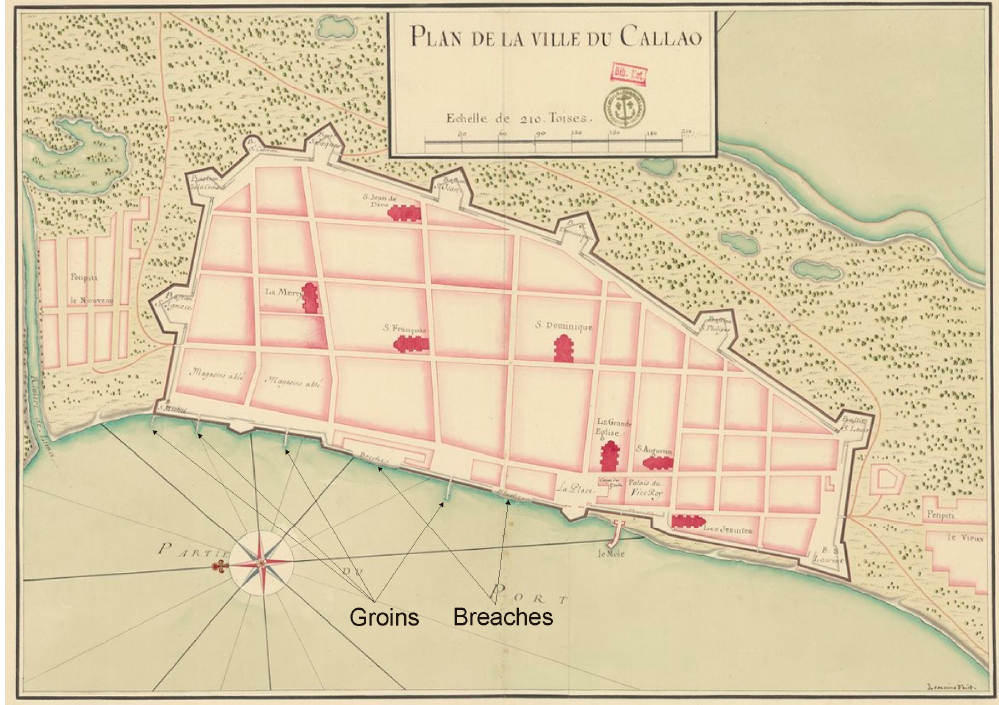
Figure 7. Groins in Callao (1724–1727) in a city plan copied by Lemoine [33]. Courtesy: Bibliothèque nationale de France.